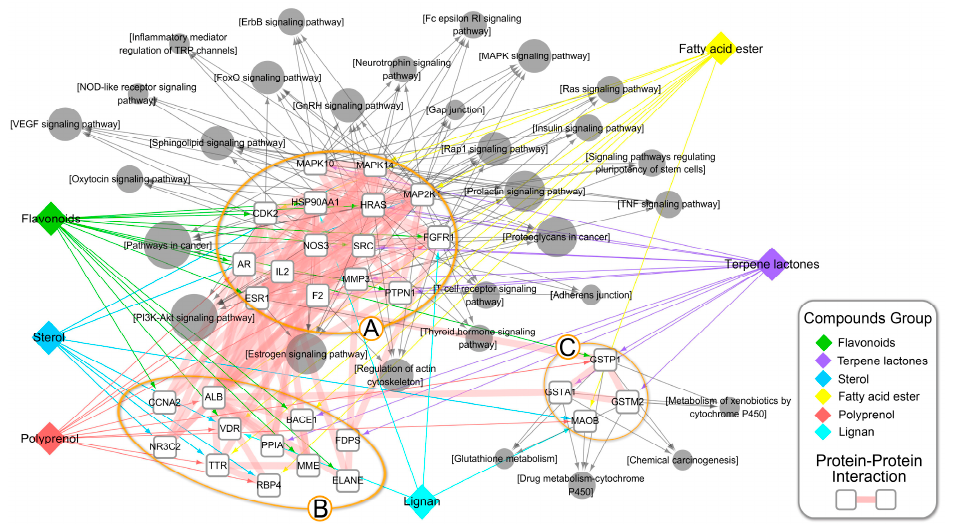
Figure 7. Illustration of the Compound-Group-Target-Pathway (CGTP) network. Diamonds in different colors represent different compound groups. Gray circles represent enriched KEGG pathway terms, and the size of each circle represents the number of genes that have been enriched. White rounded rectangles represent the top 30 putative target proteins. The wide pink bands represent the protein-protein